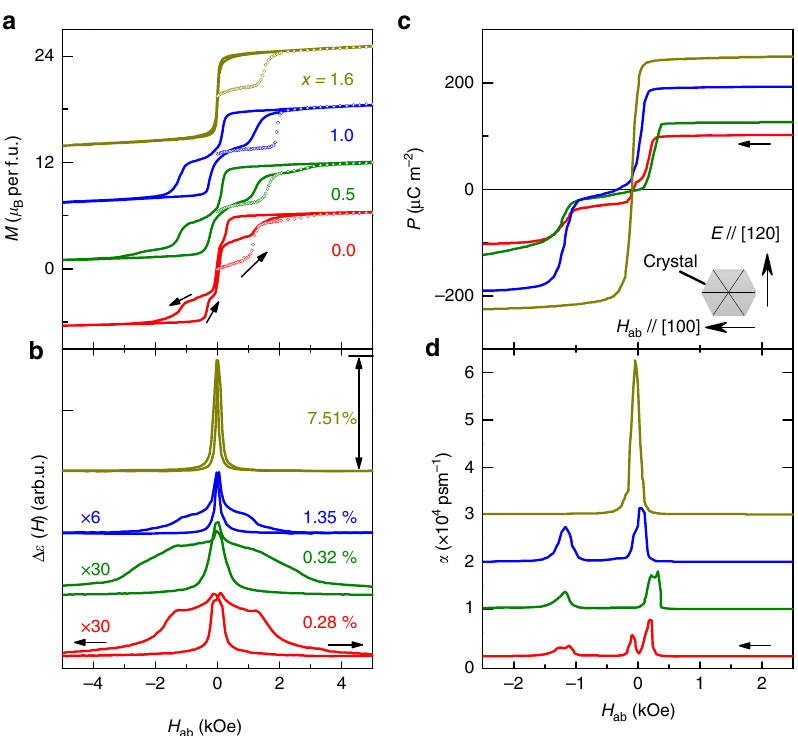
Fig. 2 Spin-driven multiferroicity in Ba 2- x Sr x Mg 2 Fe 12 O 22 at 10 K. a M-H ab hysteresis loops for all samples. The initial magnetization curve and normal curves are marked by open circle and line, respectively. b The magnetic fi eld dependence of relative dielectric constant Δ ε ( H ) for all samples. Δ ε ( H ) = [ ε ( H ) − ε (5 kOe)]/ ε (5 kOe). c In-plane electric polarization as a function of H ab for all samples. The inset shows the schematic measurement con fi guration. d The direct ME coef fi cient α H as a function of H ab for all samples. The baselines are shifted vertically with constant value for clarity. A single peak of α H with a giant value of 33,000psm − 1 is obtained in x = 1.6 sample. The arrows denote the direction of scanning magnetic fi